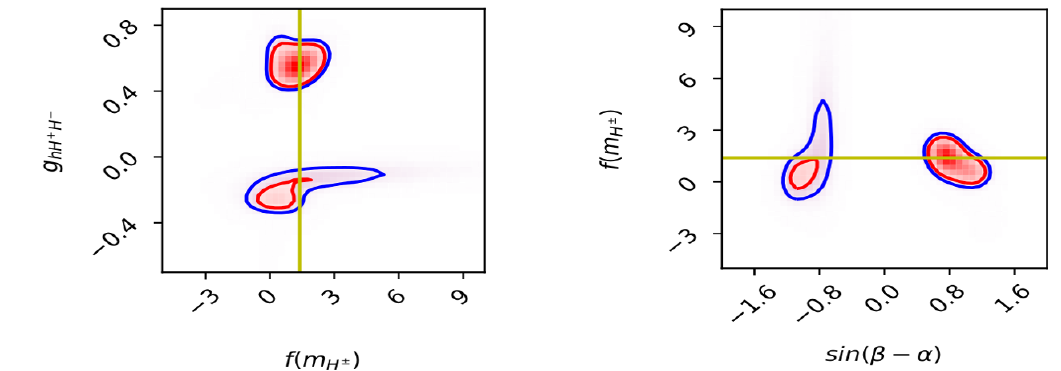
) (cid:0) H (cid:6) ) plane in (cid:12)gure 12 (left) H (cid:6) ) > 0 on the right- H (cid:6)